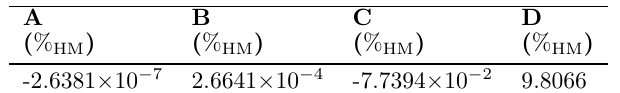
Fig. 6. Critical 235 U enrichment evaluation for UOx full-core calculations performed with DRAGON5-DONJON5. Table 10. Details of the critical enrichment prediction